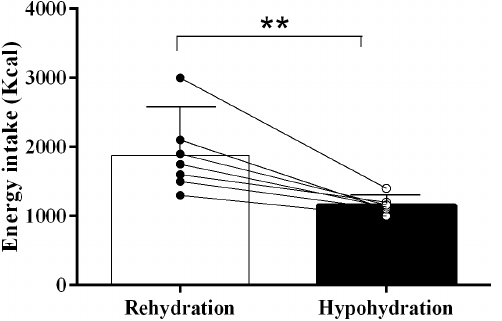
Figure 2. Post-exercise caloric intake. HY = hypohydration condition; RH = rehydration condition; Mean ± SD; ** indicates p < 0.01 . Table 1. Macronutrients intake one day before trials.